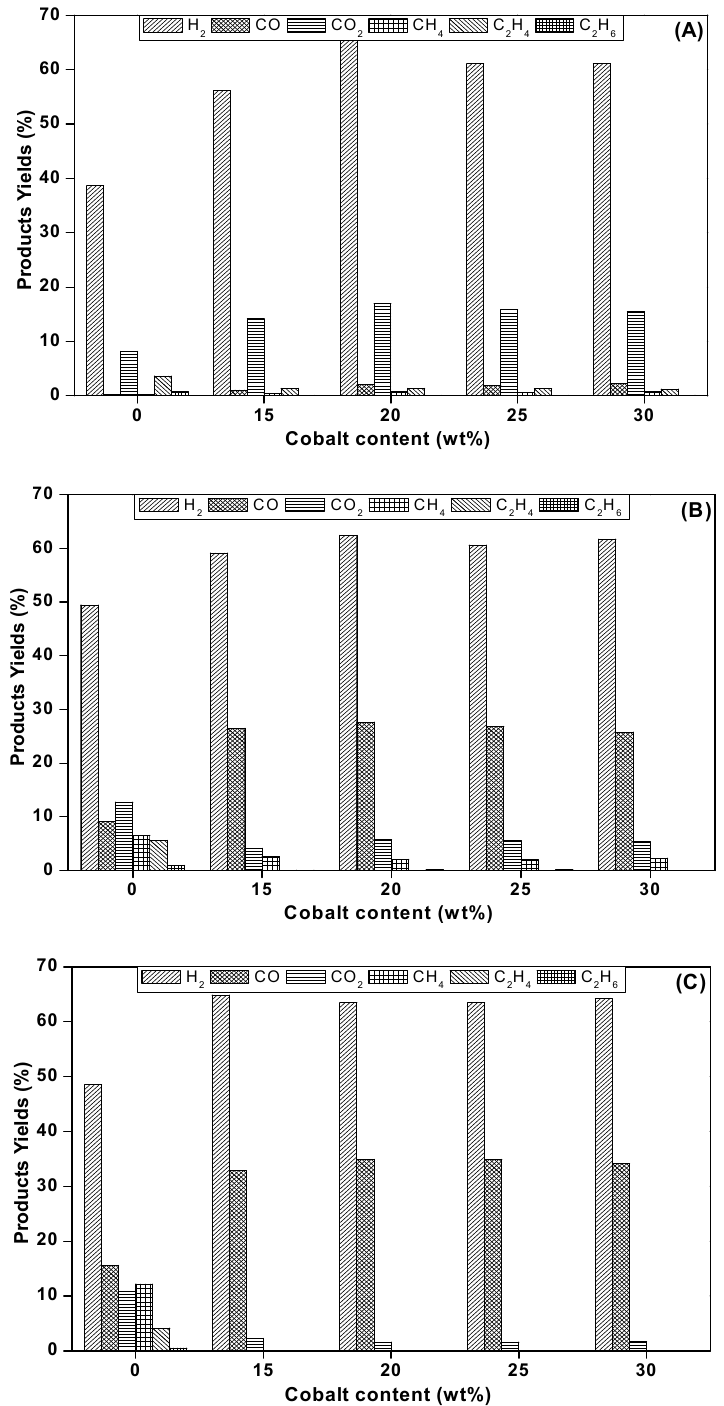
Figure 8. Effect of Co loading in Co/CeO 2 catalysts on products yield at 400 °C ( A ); 600 °C ( B ) and 800 °C ( C ). Reaction conditions: S/C = 3, m cat = 250 mg, F T = 150 cm 3 /min.